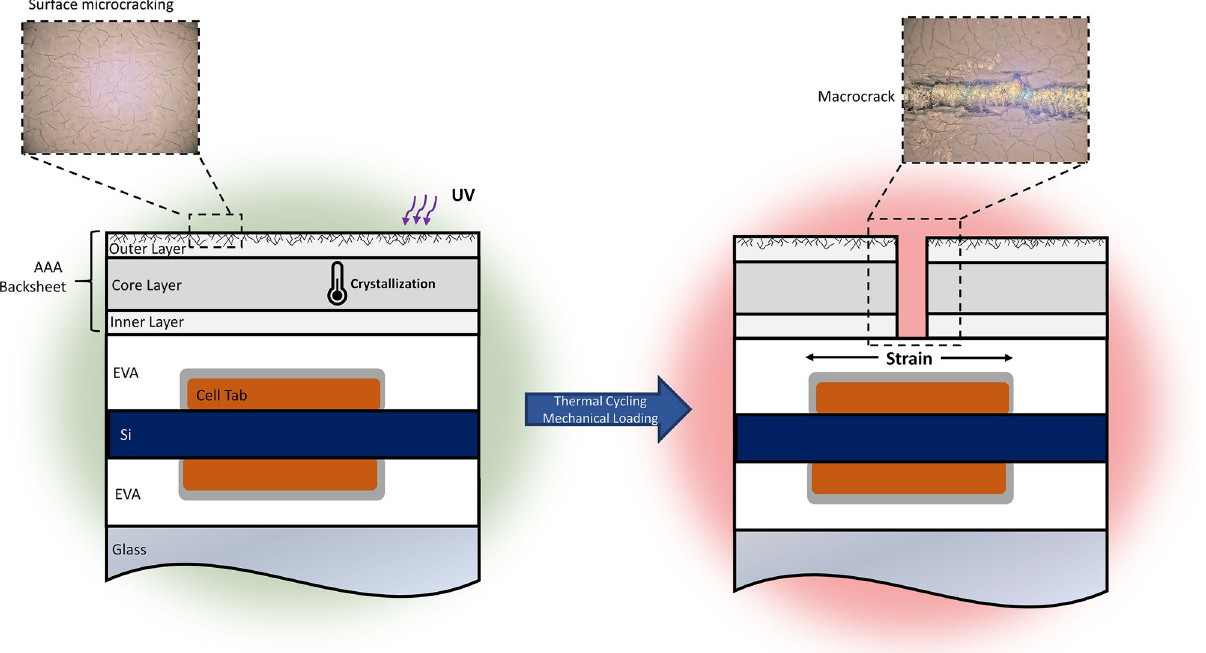
Figure 9. Schematic of the two-step process for Mode A cracking of AAA, demonstrating the required combination of stressors which are applied in C-AST. Graphic rendered using Microsoft PowerPoint (16002.12325.20032.0), https ://www.micro soft.com/en-us/micro soft-365/power point